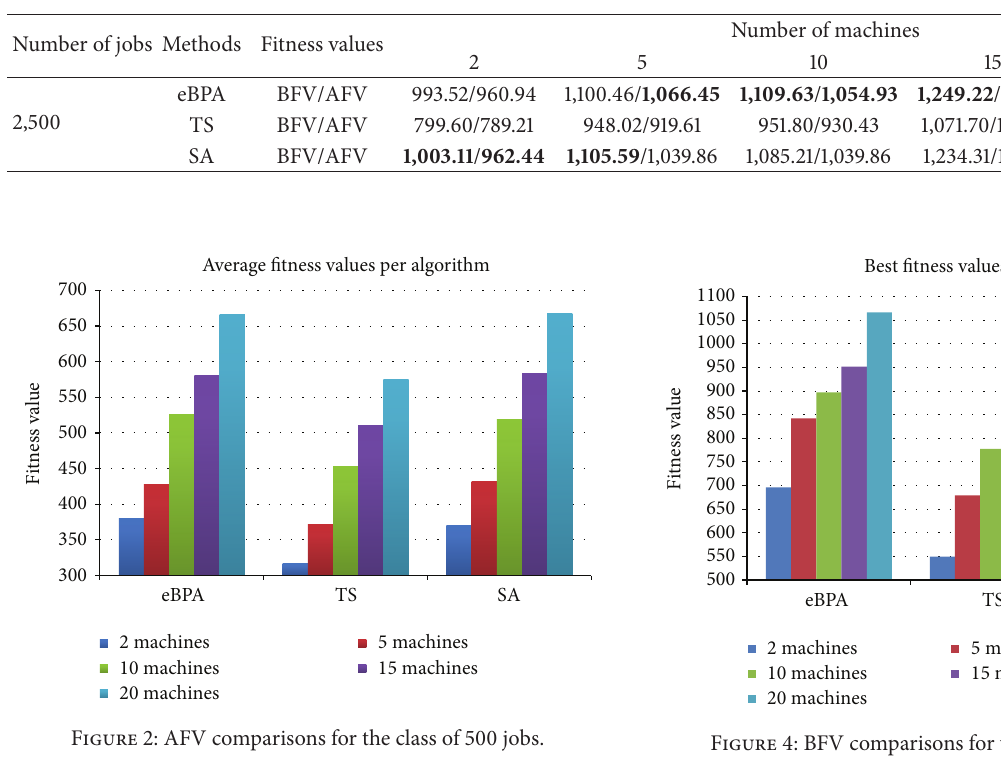
Figure 4: BFV comparisons for the class of 1,500